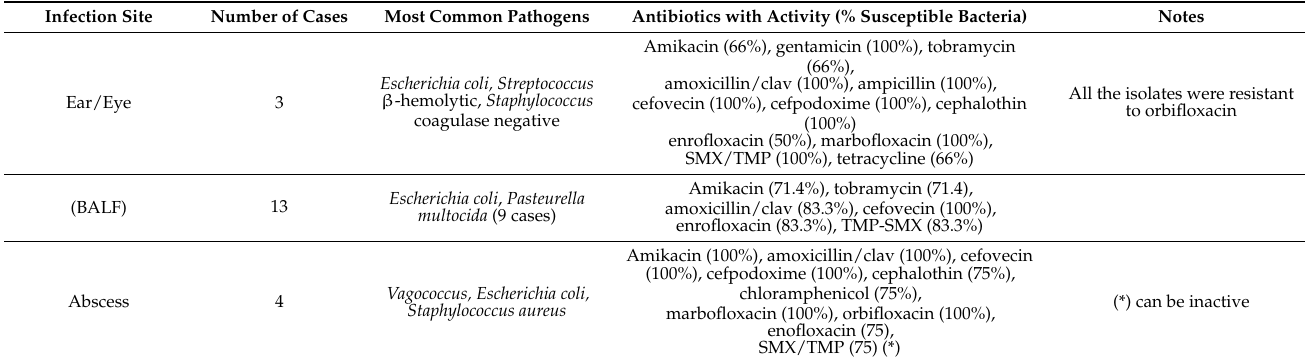
Table 2. Antibiotics with activity against infections isolated from several